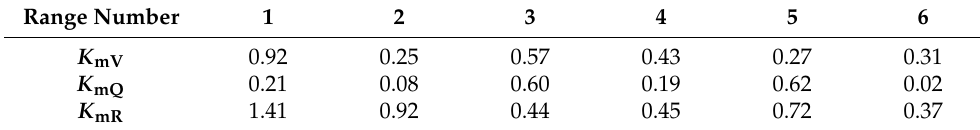
Table 5. Range of influence of parameter inconsistency on module discharge capability.